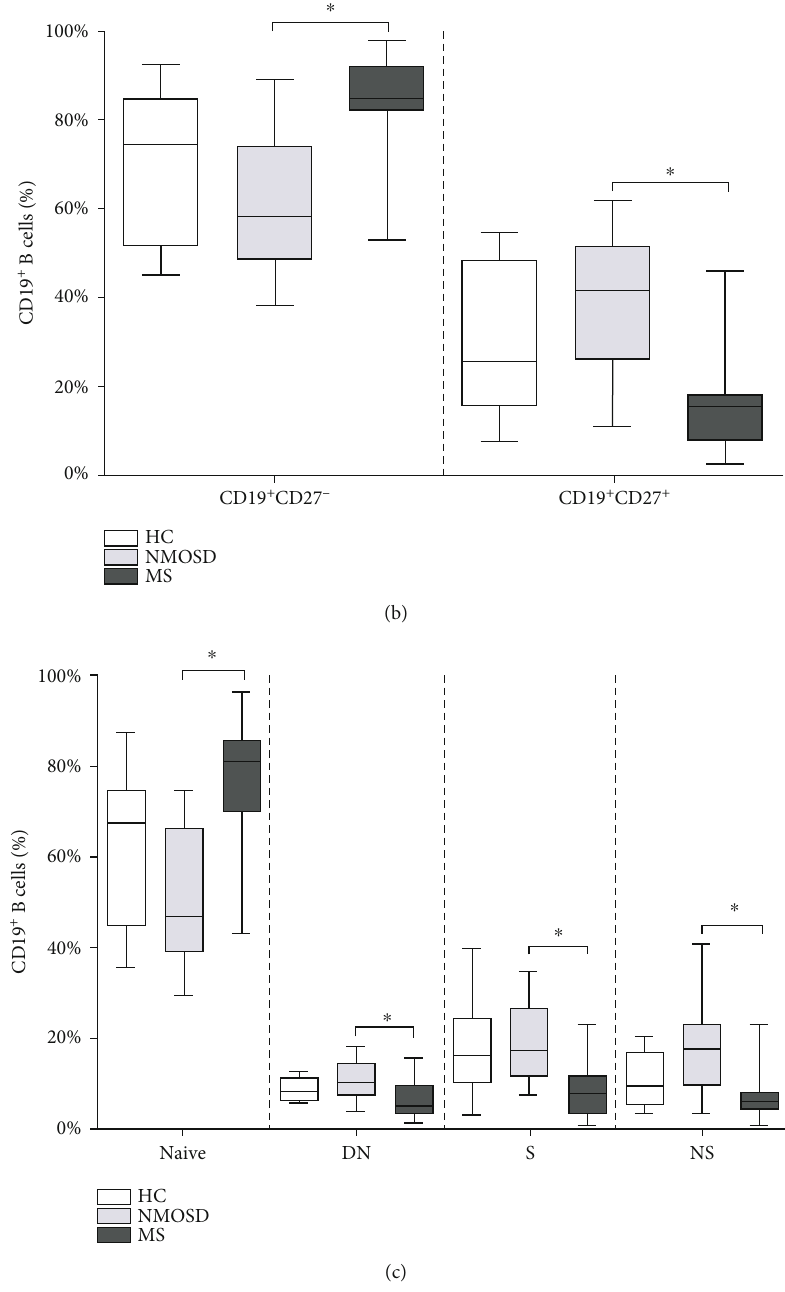
Figure 1: Analysis of B cell subsets in neuromyelitis optica spectrum disorder (NMOSD) and multiple sclerosis (MS) patients. (a) Representative fl ow cytometry plots of four subsets of peripheral blood CD19 + B cells de fi ned by CD27 and IgD labeling: CD19 + CD27 - IgD + naïve, CD19 + CD27 + IgD + nonswitched (NS) memory, CD19 + CD27 + IgD - switched (S) memory, and CD19 + CD27 - IgD - double-negative (DN) B cells. (b) Flow cytometric analysis of naïve (CD19 + CD27 - ) and memory (CD19 + CD27 + ) B cells in peripheral blood of NMOSD, MS, and healthy controls (HC). (c) Flow cytometric analysis of the de fi ned four B cell subpopulations in peripheral blood of NMOSD, MS, and healthy controls (HC). Boxes show interquartile ranges (IQR); whiskers indicate the lowest and highest values; horizontal lines represent medians; n = 6 HC, n = 12 NMOSD, and n = 15 MS; ∗ p < 0 : 05